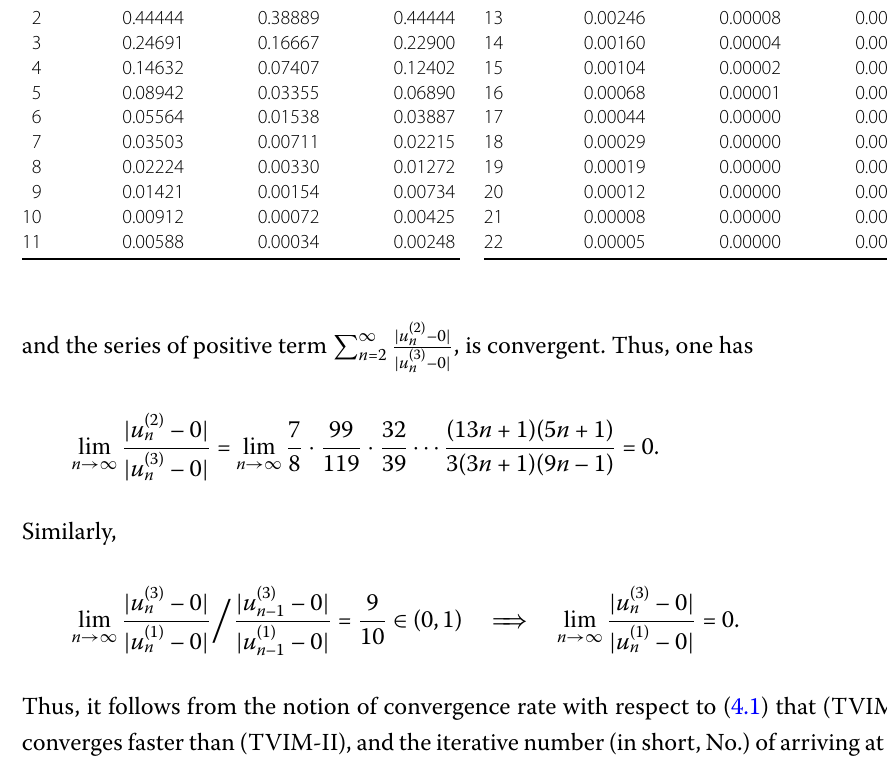
Table 1 Numerical results for (TSVIM), (TVIM-I) and (TVIM-II) No. (TSVIM) (TVIM-I)